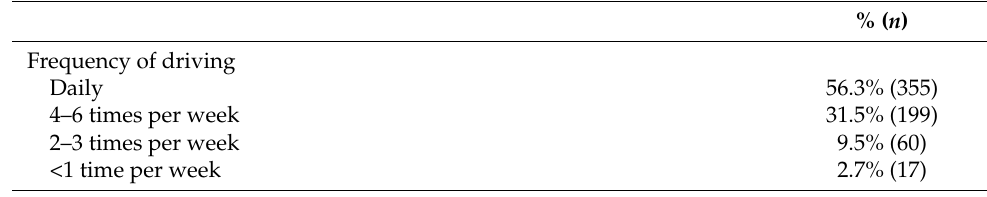
Table 2. Participants’ driving characteristics ( n =